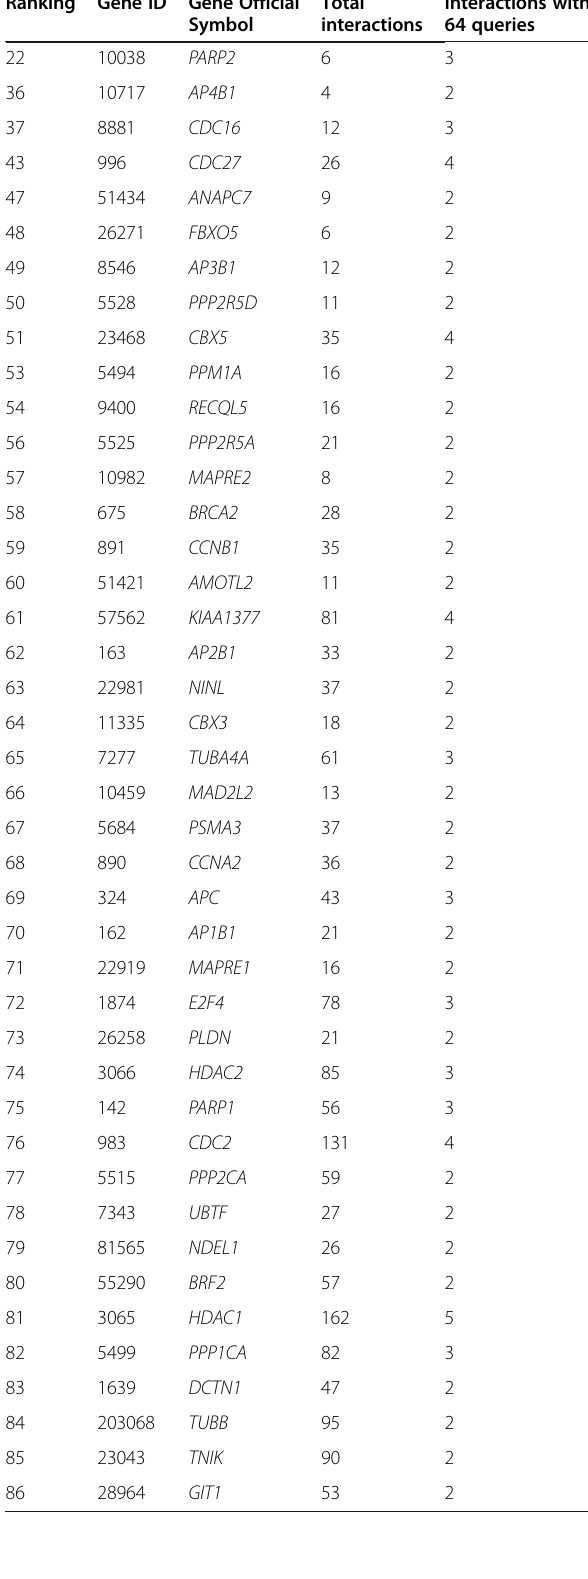
Table 3 Top-ranking non-query genes whose encoded proteins interact with 64 core centromere-kinetochore components